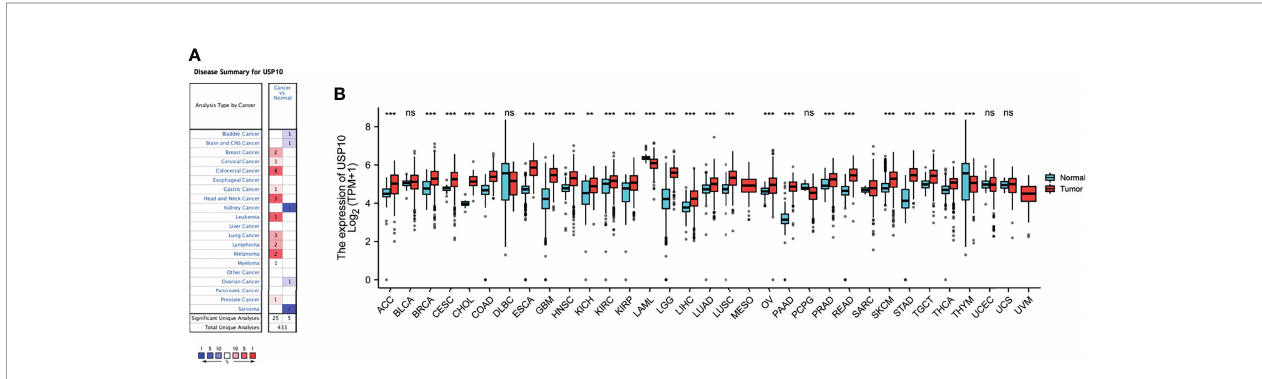
FIGURE 1 | The mRNA expression level of USP10 in pan-cancer. (A) Oncomine data showing enhanced or reduced USP10 expression in various tumor tissue types and in normal tissues. (B) TGCA data showing the expression levels of human USP10 in different types of cancer, with GTEx data as a control. ** P < 0.01; *** P < 0.001. NS, no signi fi